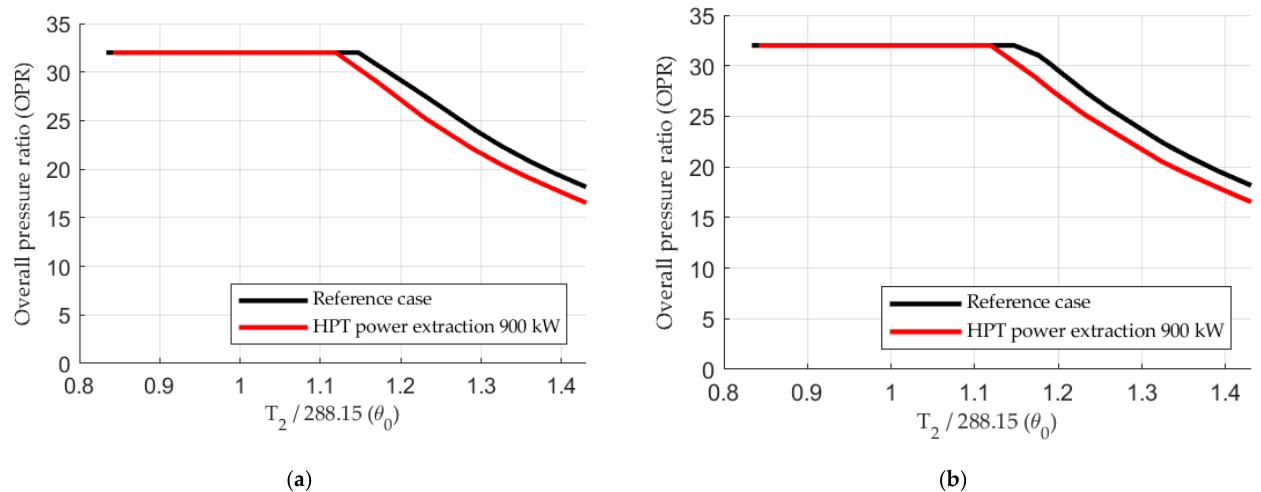
Figure 10. OPR plotted versus θ 0 (T t2 /288.15); ( a ) Maximum augmented power; ( b ) Maximum non-augmented power.